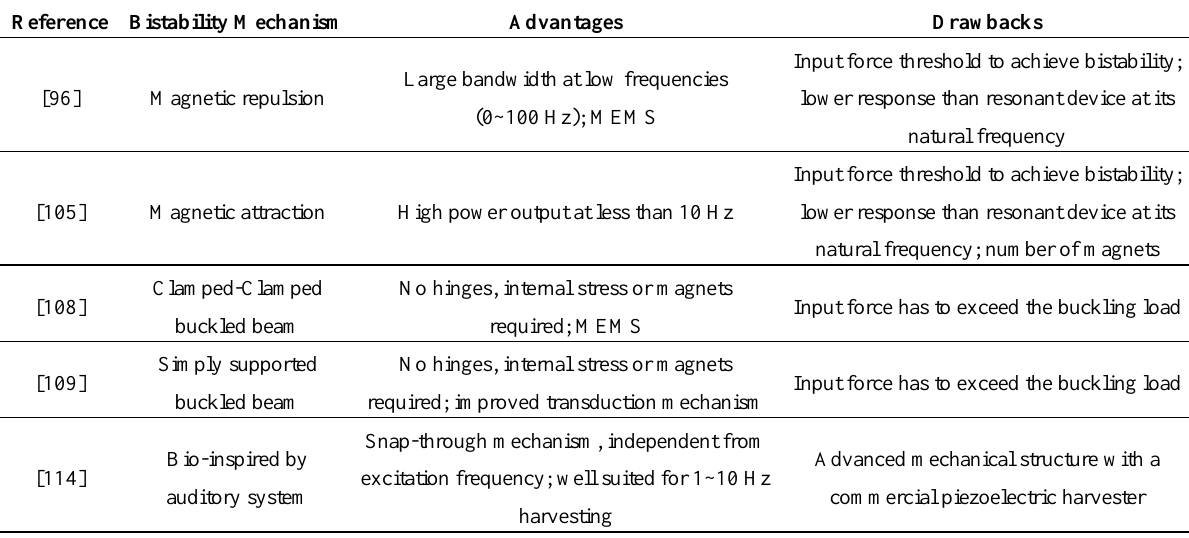
Table 3. Comparison of some non-resonant devices. Bistable devices can be